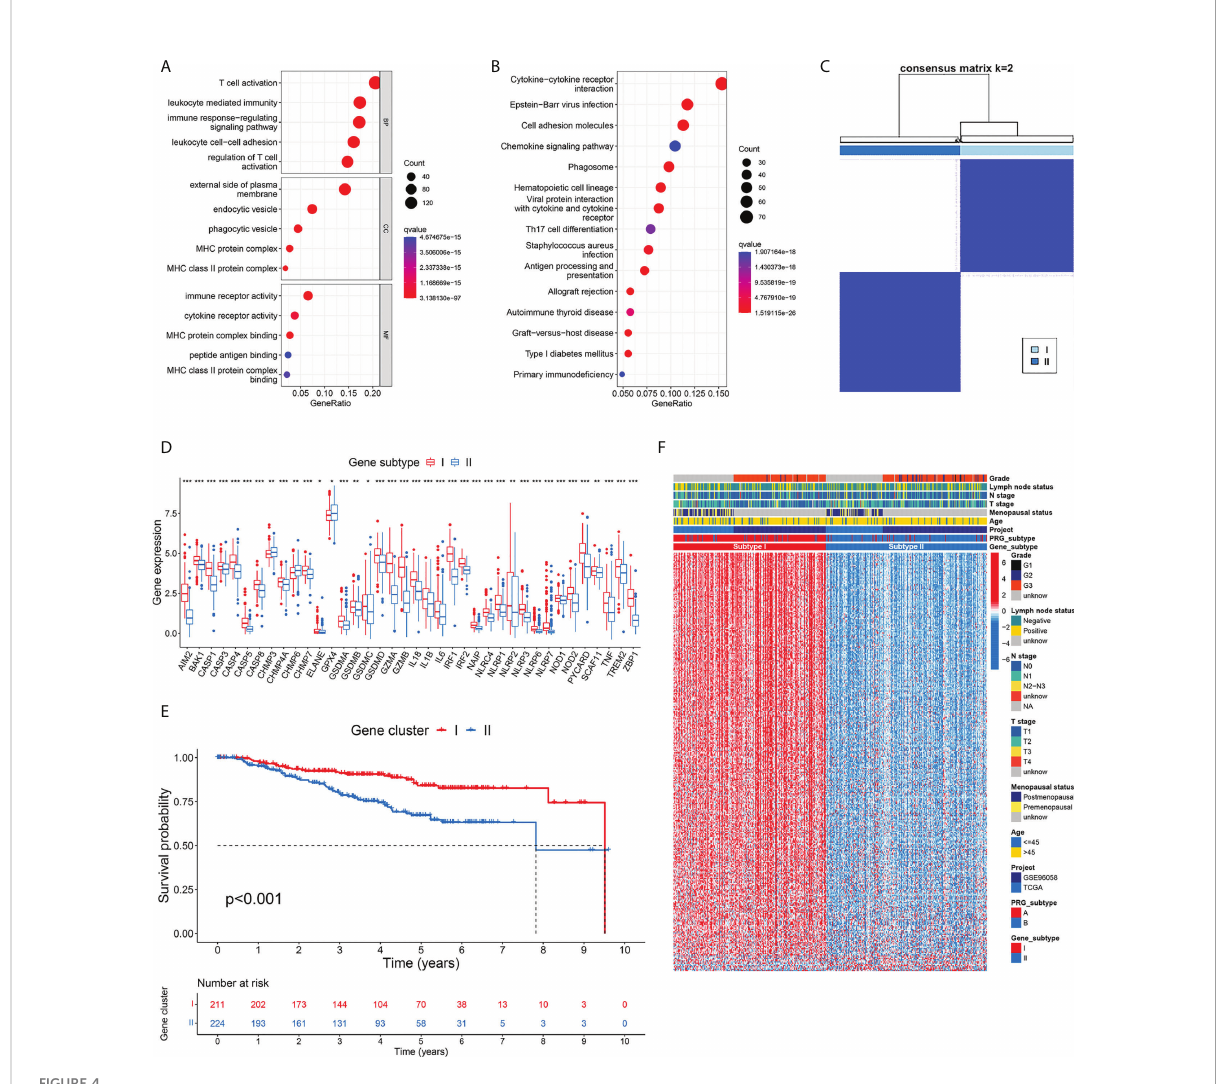
FIGURE 4 Development of gene subtypes based on differentially expressed genes between PRG subtypes. (A , B) GO and KEGG enrichment of DEGs identi fi ed between two PRG subtypes. (C) Consensus matrix heatmap de fi ned two gene subtypes based on 346 prognostic DEGs. (D) Thirty-eight PRGs were differentially expressed between two gene subtypes. (E) TNBC patients de fi ned as gene subtype I showed signi fi cantly better OS. (F) Comparison of gene expression and phenotype features between two gene subtypes. * p < 0.05, ** p < 0.01, *** p <